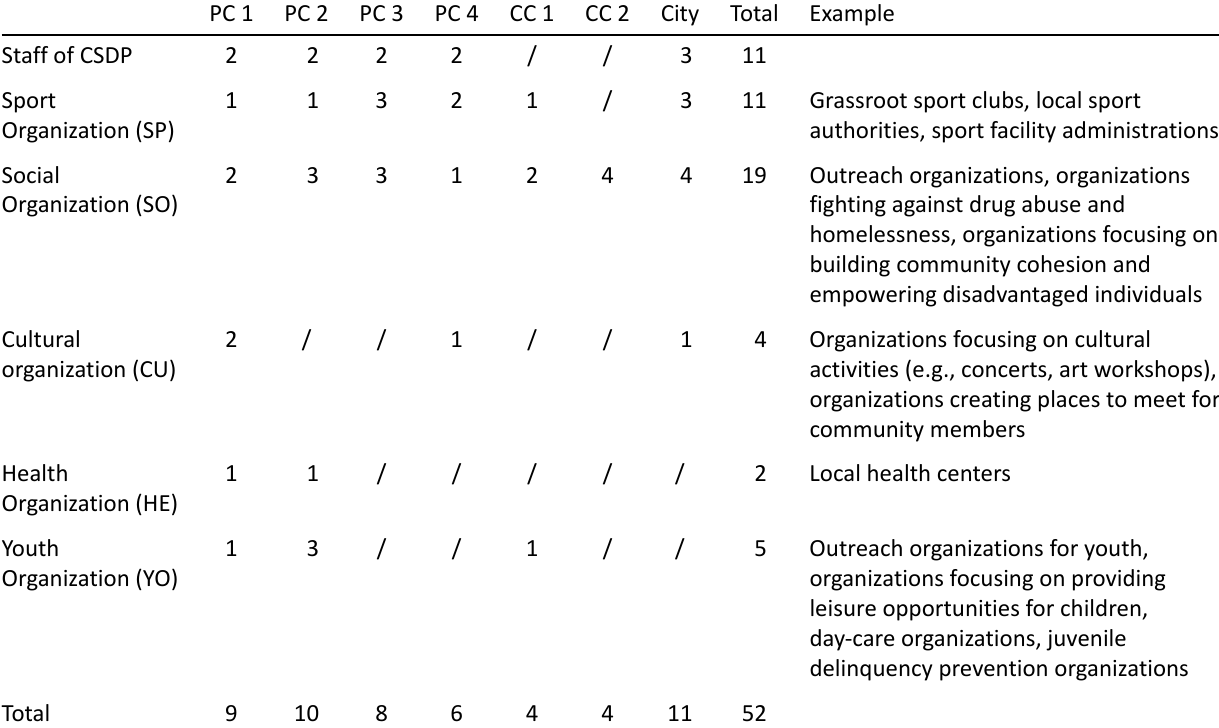
Table 1. Overview of interviewees of different organizations in program communities, control communities and at the city